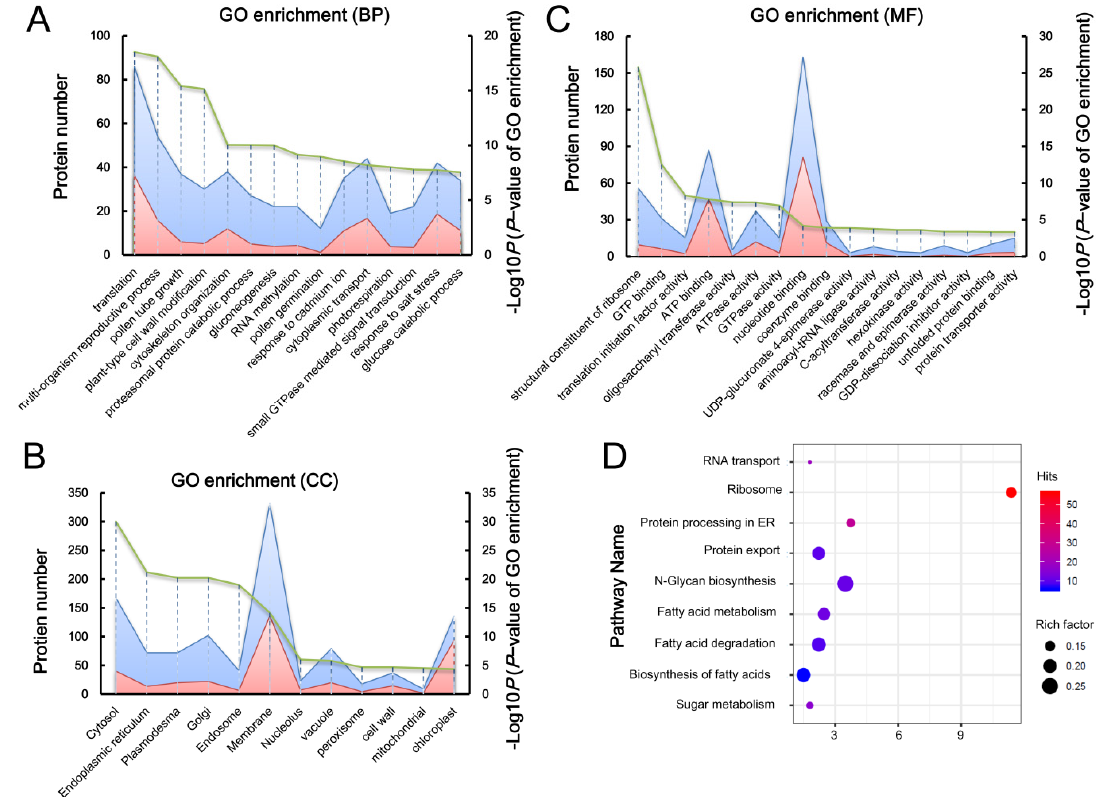
Figure 2. The GO and KEGG (Kyoto Encyclopedia of Genes and Genomes) classification of ROP1-associated protein in Arabidopsis pollen tubes. According to P value (green line), protein number (blue) and significance (pink), the 15 most significant biological processes ( A ), the 12 most significant molecular functions ( B ), and the most significant 12 subcellular localizations ( C ) and KEGG enrichment results ( D ) of ROP1-associated proteins were shown.